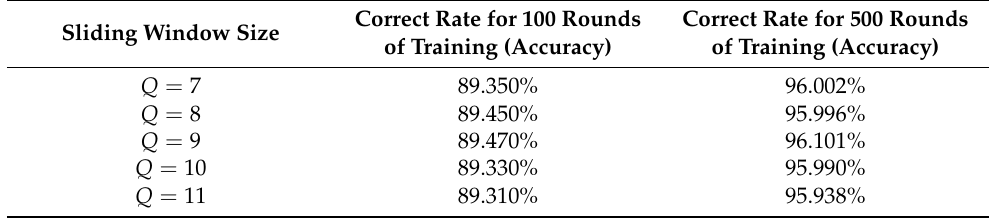
Table 1. Determine the sliding window